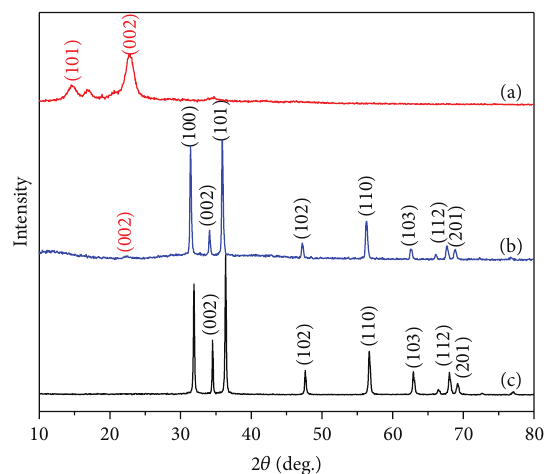
Figure 2: XRD patterns of (a) bacterial cellulose, (b) ZnO/BC hybrid fiber, and (c) ZnO.